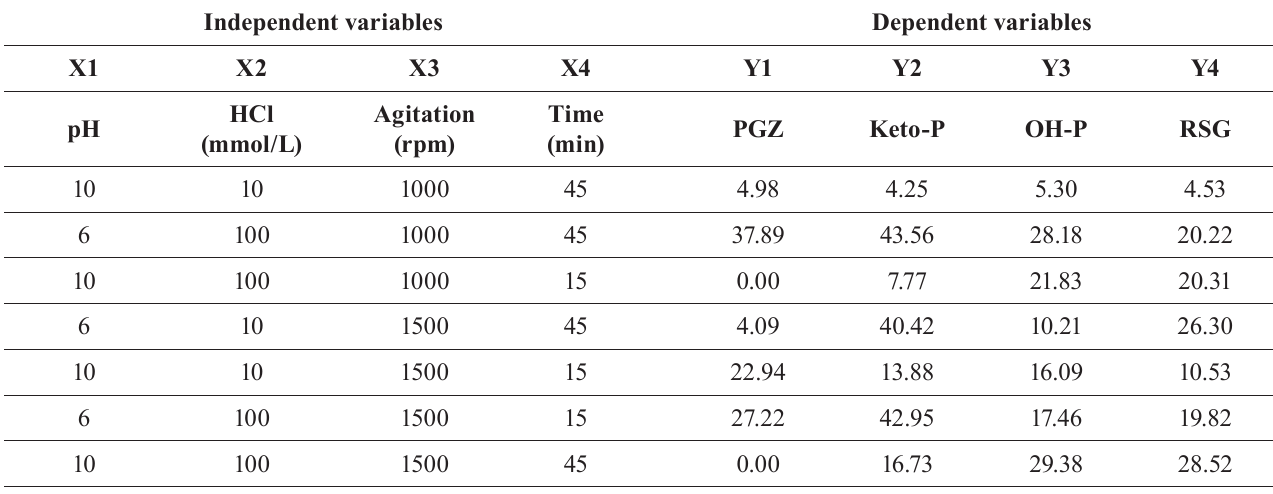
TABLE I - I ndependent (X1, X2, X3, and X4) and recovery factor extraction (%) - dependent variables (Y1, Y2, Y3, and Y4), fractionate factorial design matrix, and results of experimental design for pioglitazone (PGZ) and its metabolites (Keto-P and OH-P)